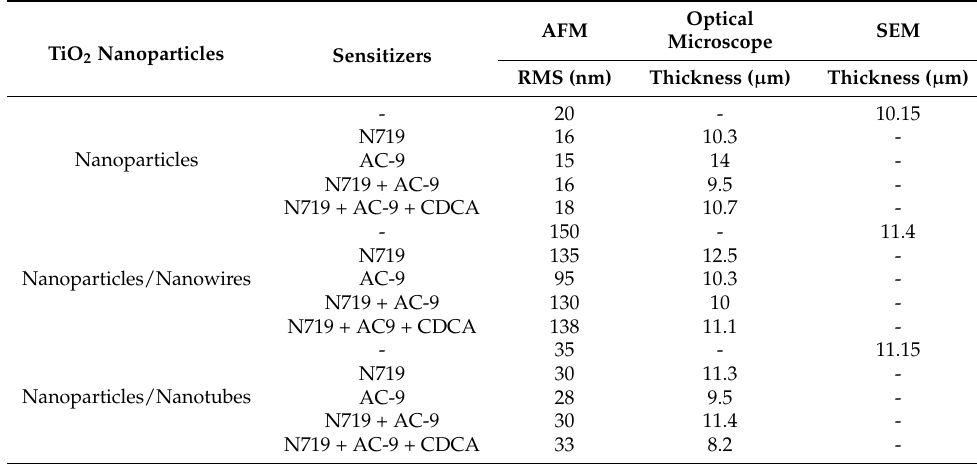
Table 1. Thickness and roughness parameters of TiO 2